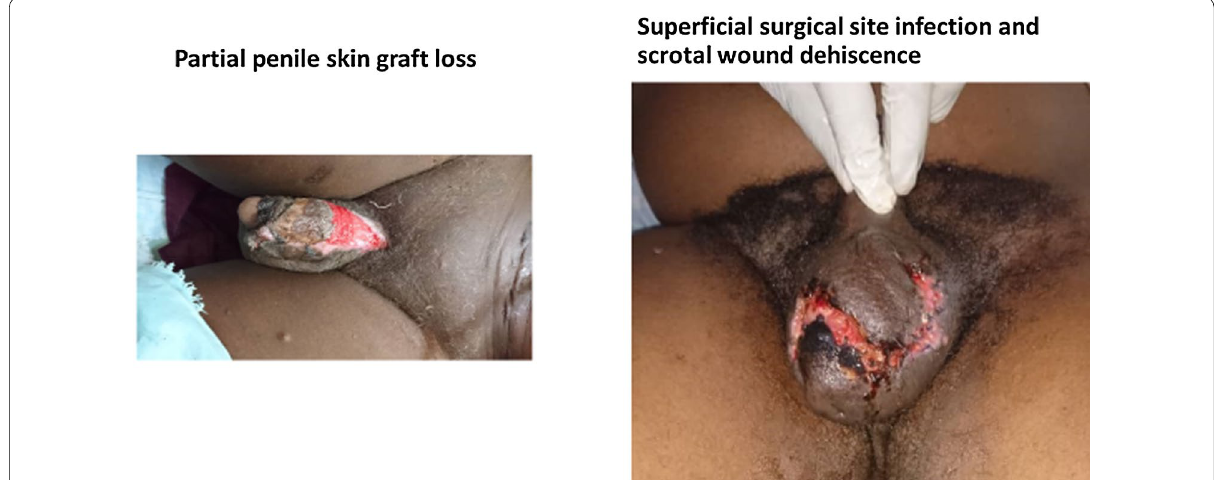
Fig. 5 Complication: partial penile skin graft loss and superficial wound dehiscence secondary surgical site infection post‑scrotal advancement flap